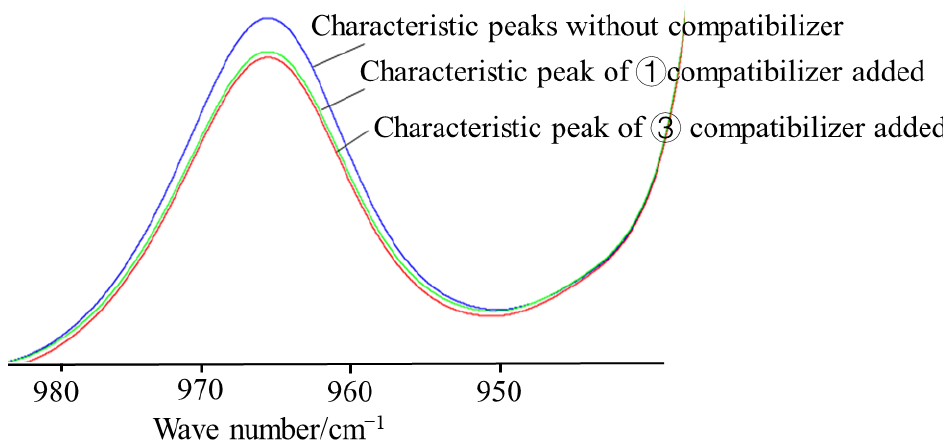
Figure 5. Infrared spectra of SBS-modified asphalt with and without compatibilizer at 966 cm − 1 . Table 5. Test result of peak area ratio.